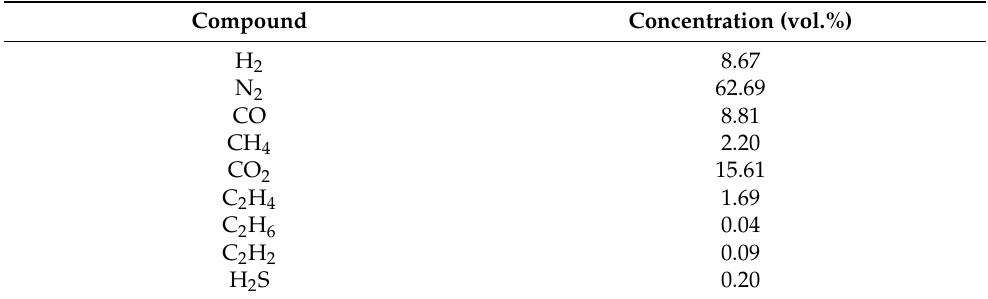
Table 2. Main producer-gas composition assumed for dewatered-sludge gasification [28].